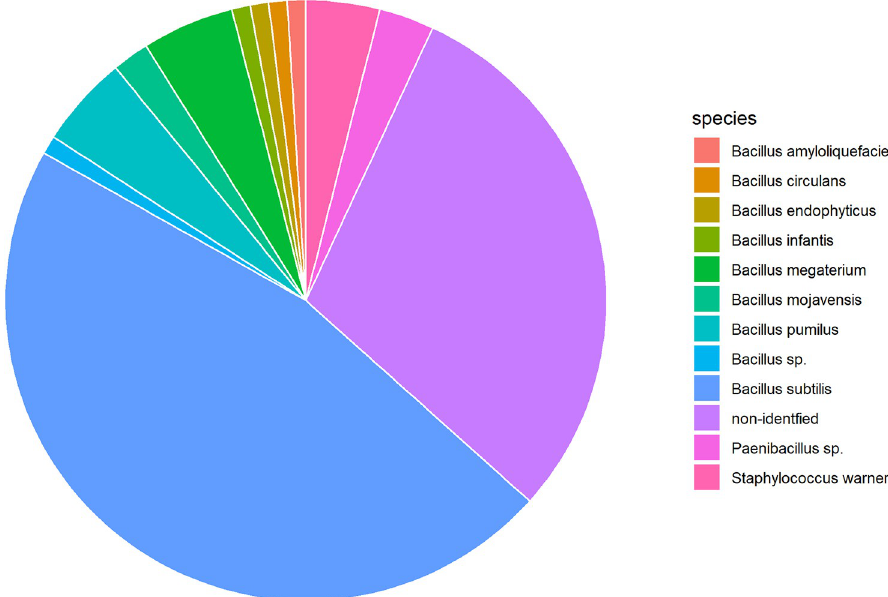
Fig 2. Identification of colonies growing from ethanol resistant bacterial spores by MALDI-TOF. The combined results of two different fecal samples are presented.